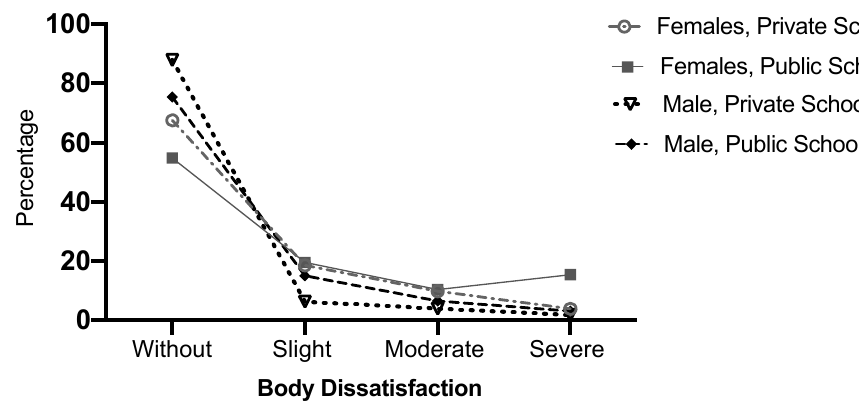
Figure 4. Degree of body dissatisfaction by sex and school type, expressed in percentages.